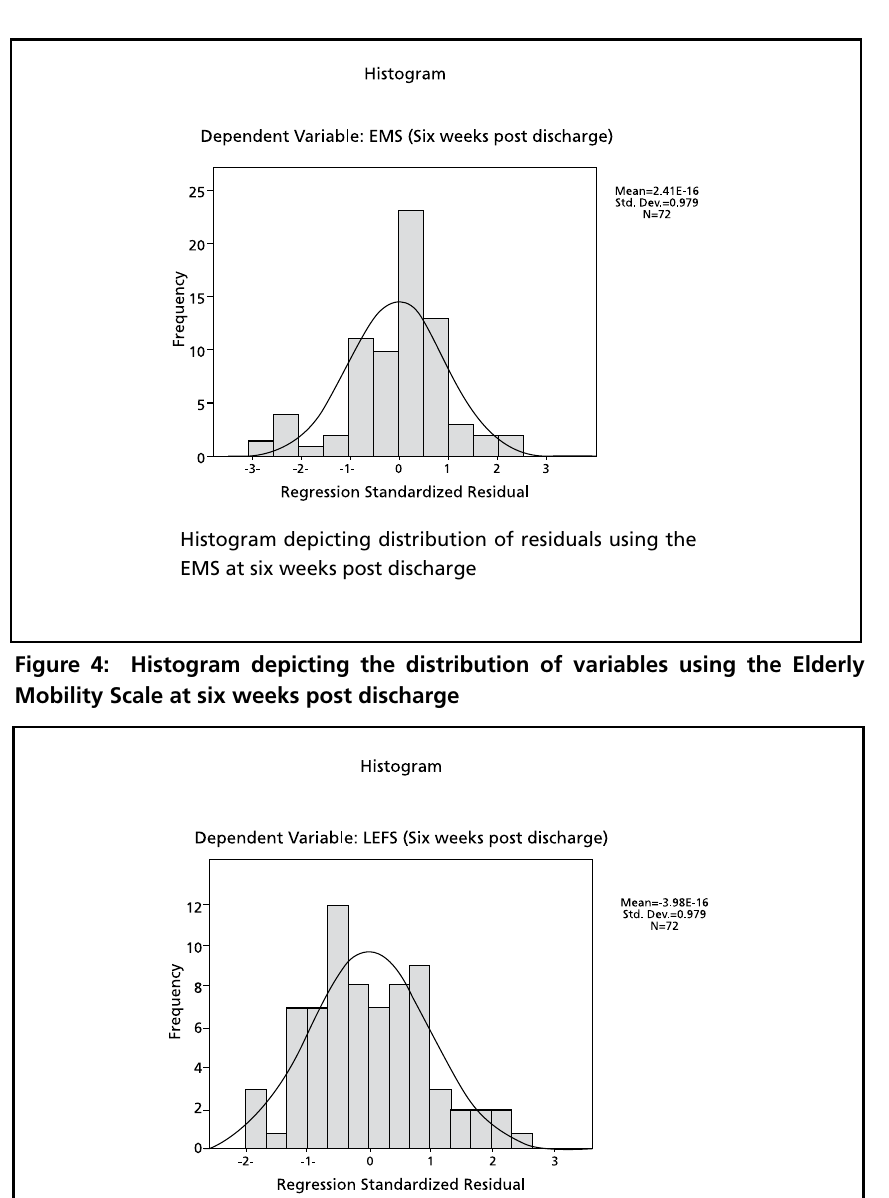
histogram depicting distribution of residuals using the leFs at six weeks post